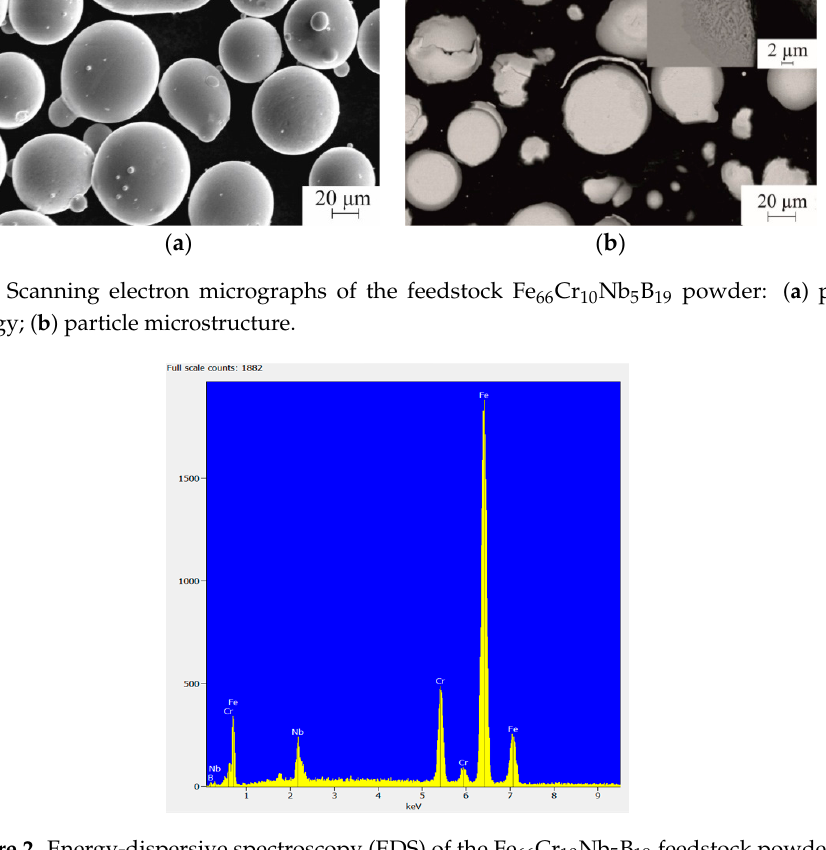
Figure 2. Energy-dispersive spectroscopy (EDS) of the Fe 66 Cr 10 Nb 5 B 19 feedstock powder.